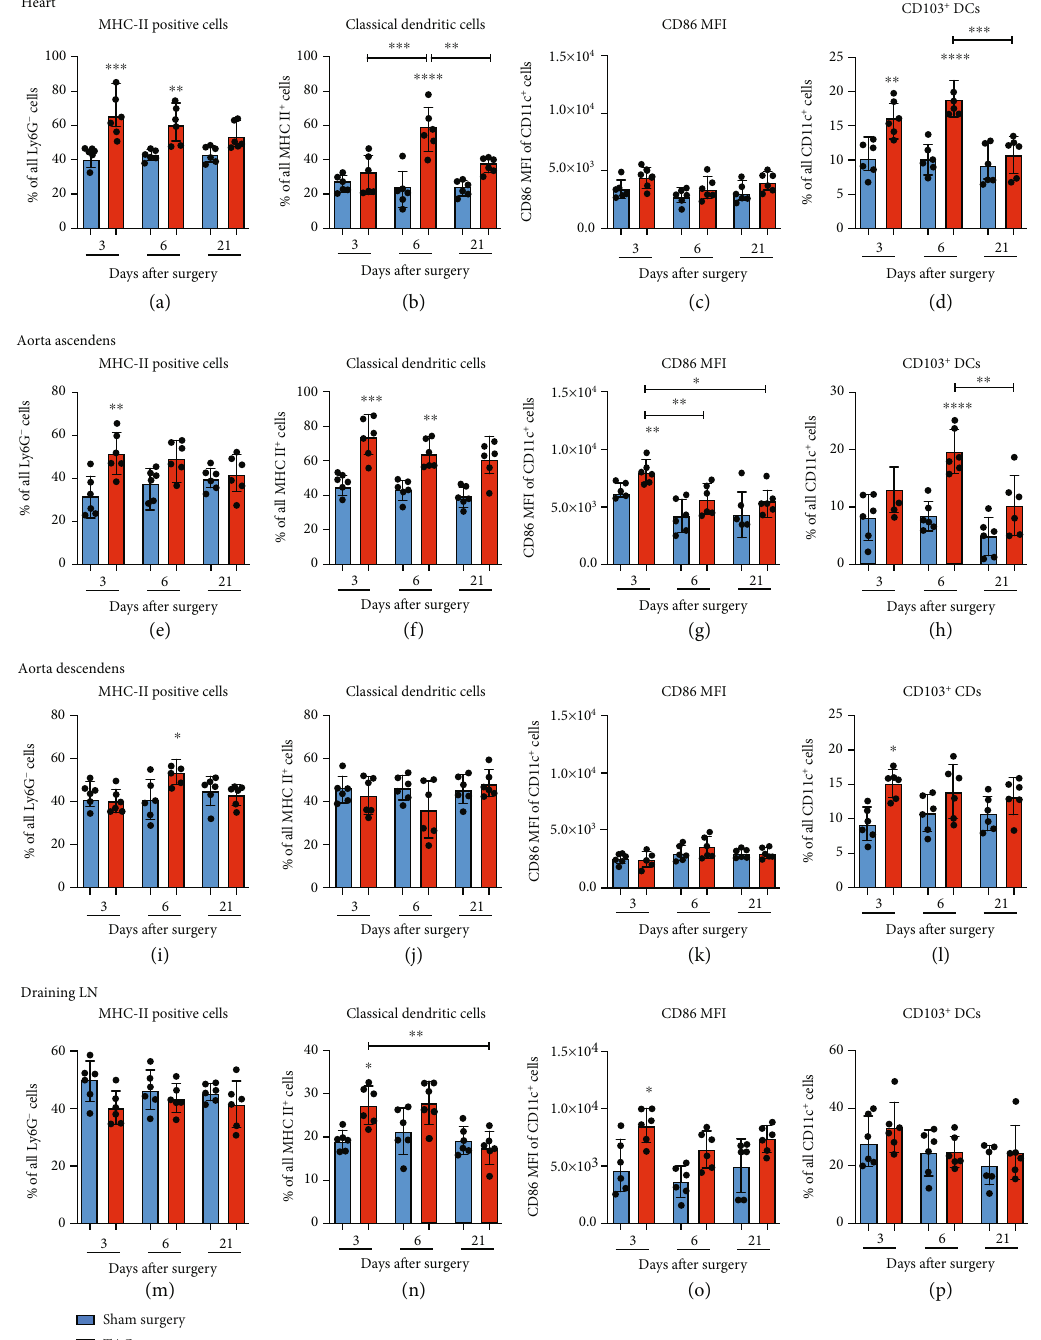
Figure 5: TAC provoked the response of the DC compartment in the myocardium, aorta ascendens, aorta descendens, and draining lymph nodes. (a) – (p) The total of the MHC-II + cells was determined from the fraction of CD45 + Ly6G - cells. The population of cDCs was de fi ned using the CD11c surface staining. CD86 MFI was calculated from the population of all cDCs. The population of CD103 + cDCs was determined based on the results of the CD103 surface staining. ∗ The above individual columns indicate the signi fi cant di ff erences between the TAC and respective sham group; ∗ P < 0 : 05 , ∗∗ P < 0 : 01 , ∗∗∗ P < 0 : 001 , and ∗∗∗∗ P < 0 : 0001